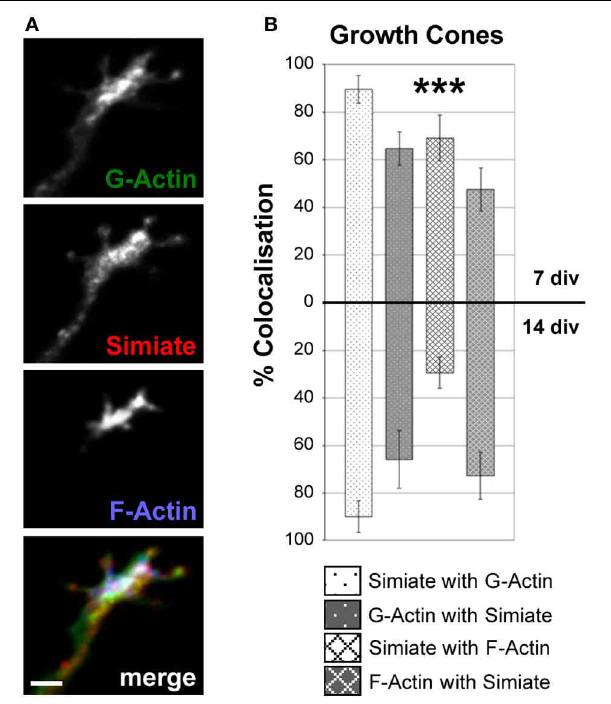
FIGURE 5 | Simiate colocalizes with G- and F-Actin in growth cones. (A) An example of Simiate and G- as well as F-Actin colocalizing in a growth cone of a 7 div neuron from a low density culture of primary hippocampal cells. Scale bar: 2 μ m. Endogenous F-Actin was labeled with Phalloidin, while DNaseI was used to identify G-Actin. (B) Quantification of the percental colocalization. Please note that growth cones were not differentiated into dendritic or axonal growth cones, but since dendritic growth cones are superior in numbers, most growth cones analyzed are